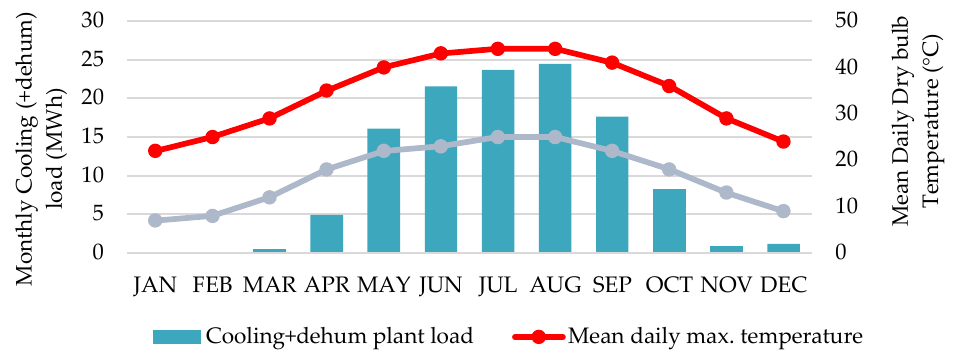
Figure 9. Monthly cooling and dehumidification load against average external temperatures in Riyadh.